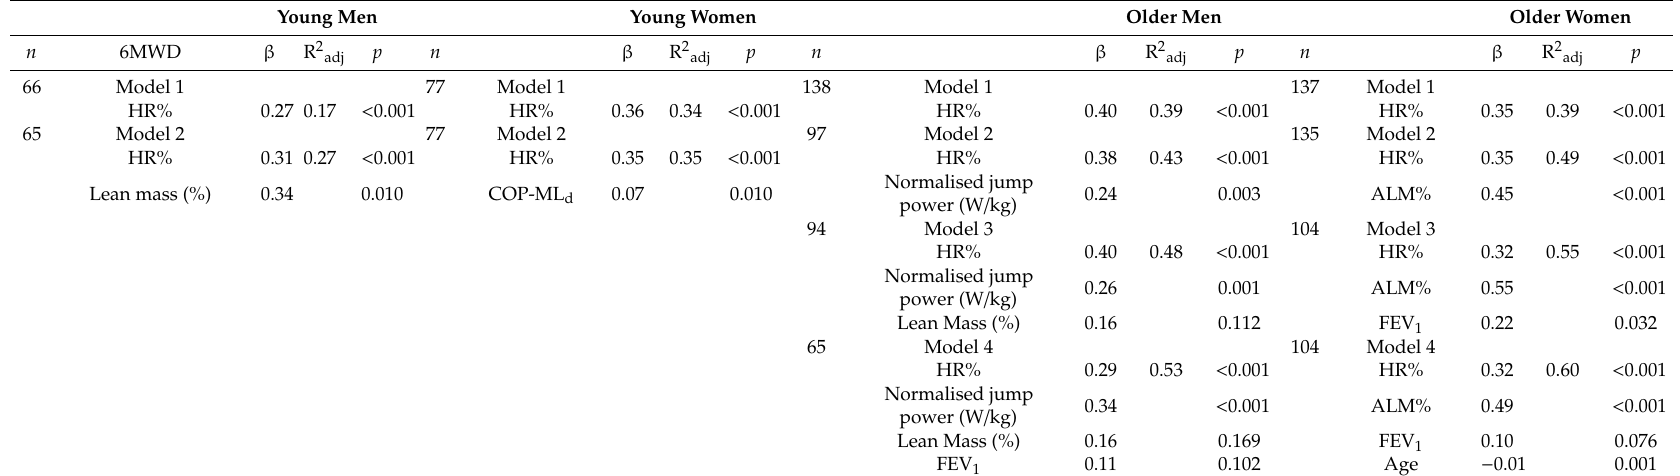
Table 5. Parsimonious multivariate regression models with the six-minute walk distance as the dependent variable and body composition and physiological variables as independent variables.